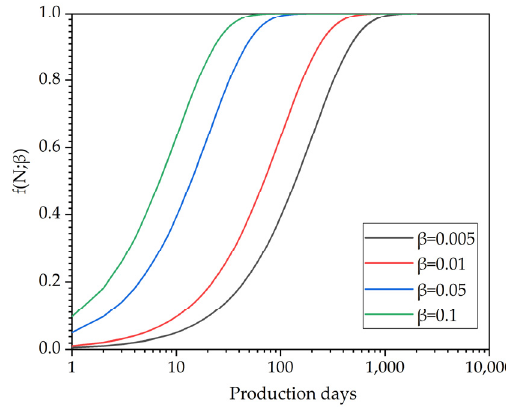
Figure 6. Sensitivity analysis of f ( N; β ) .